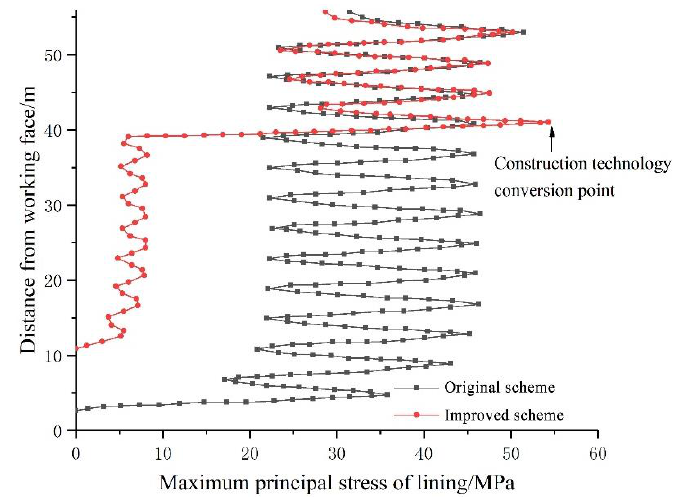
Figure 17. Major principal stress curve for the lining.